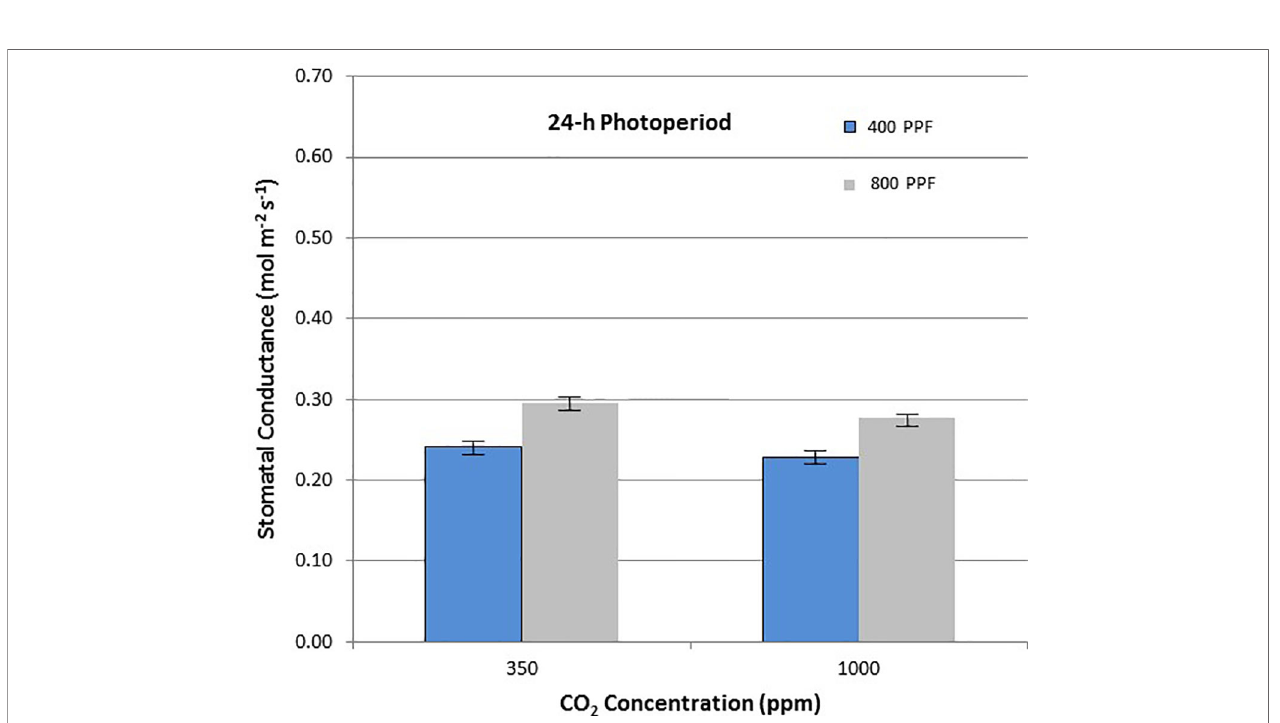
FIGURE 9 | Comparison of time-averaged stomatal conductance rates taken at 21, 28, 35, 42, 56, 70, and 84 days after planting for all cultivars grown under 24-h (continuous) light at two [CO 2 ] concentrations, and two photosynthetic photon fl ux (PPF) levels. A total of n = 36 measurements were taken at each of the 7 dates, for a total 252 total measurements. Error bars indicate the standard error of the mean for average measurements at each